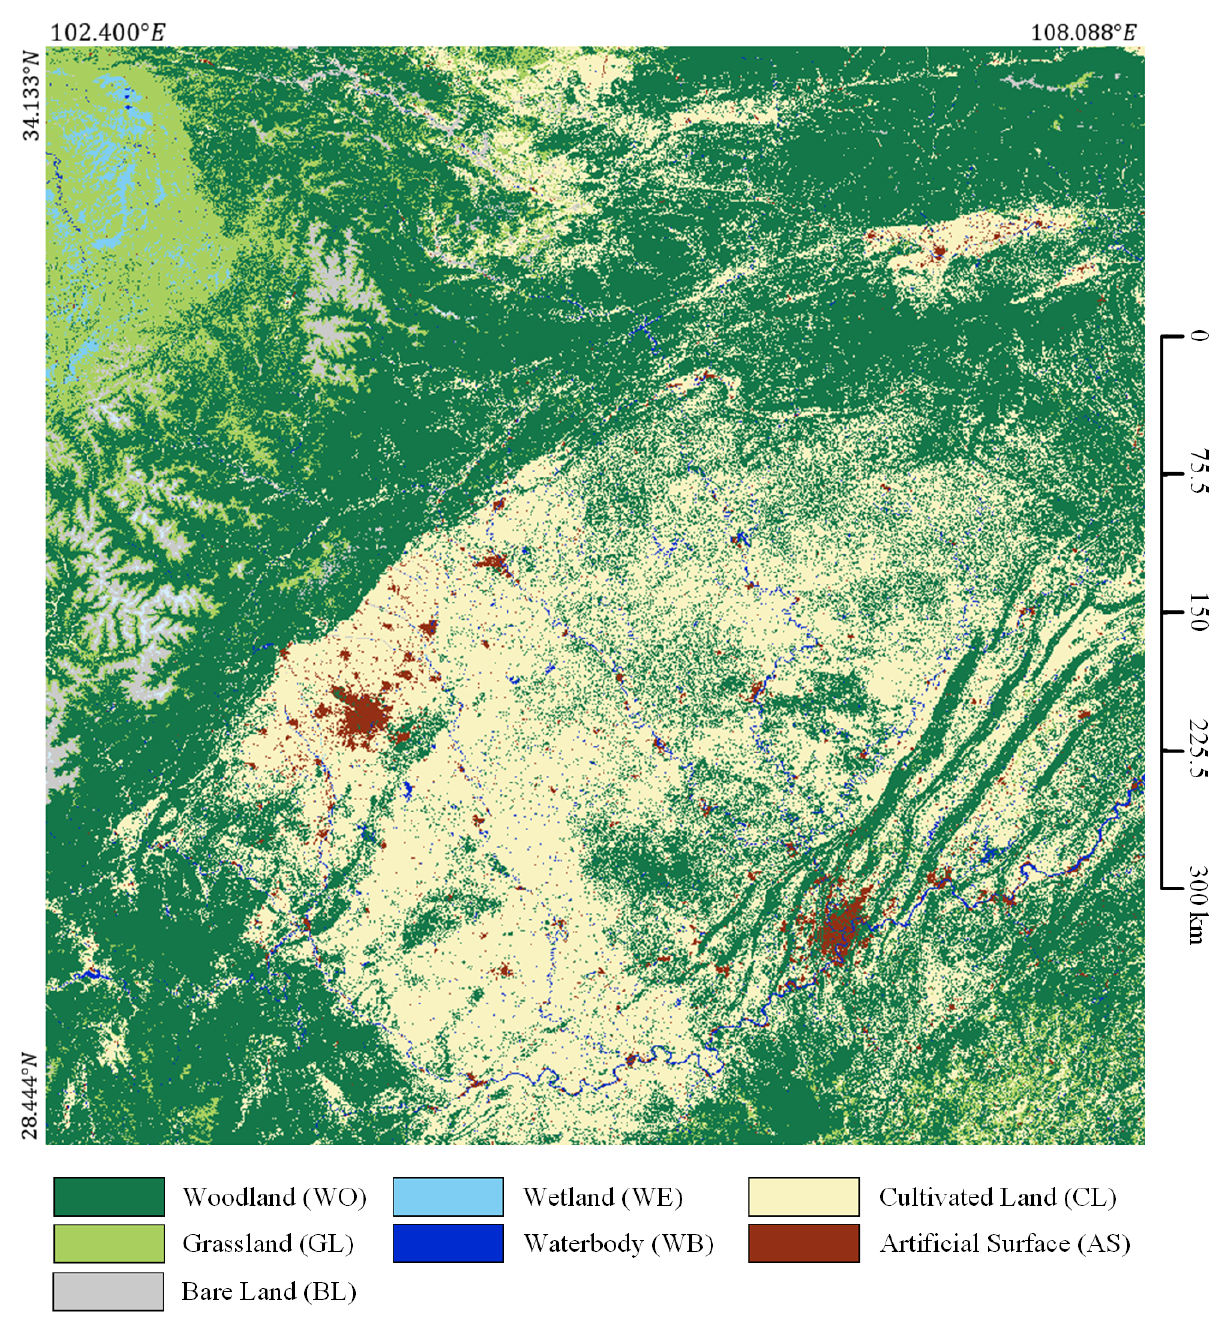
Figure 18. Large-scale classification results in parts of Southwest